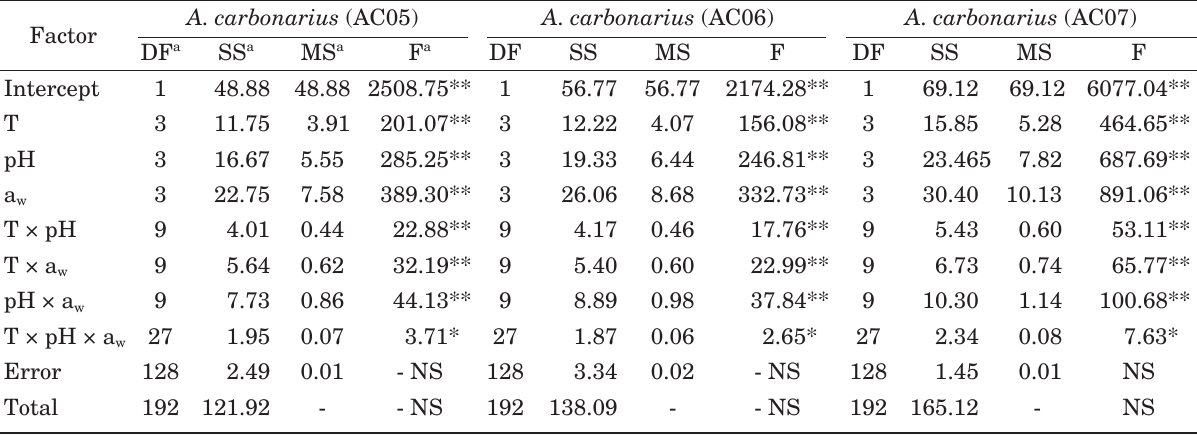
Table 4. Analysis of variance of the effect of temperature, pH and water activity on the production of OTA by three strains of A. carbonarius grown on YES (yeast extract sucrose) agar for 9